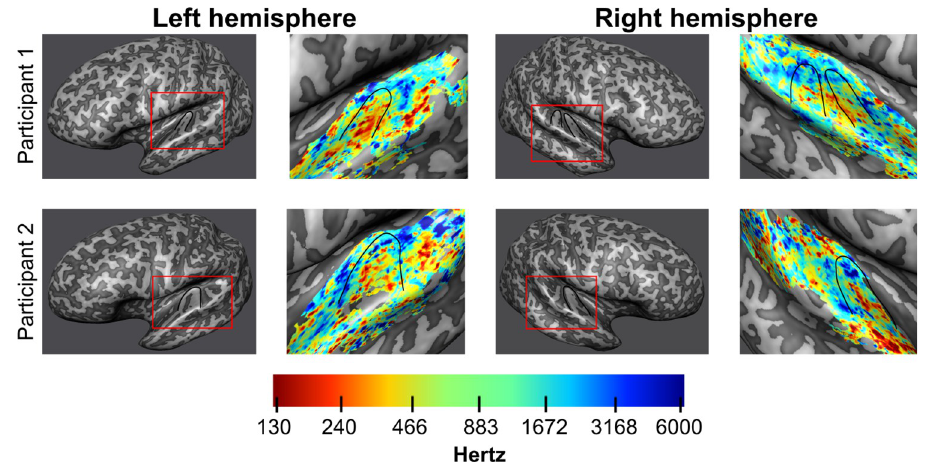
Fig 6. Tonotopic maps VASO. Inflated mid-gray matter surface meshes were created to visualize tonotopic maps coming from the VASO data. Red boxes outline the part of the mesh from which the tonotopic data was sampled. Heschl’s gyrus is outlined in black. On the right of each inflated surface, tonotopic maps are displayed for both hemispheres of the two participants. The expected tonotopic high-low-high frequency preference gradient is respected.